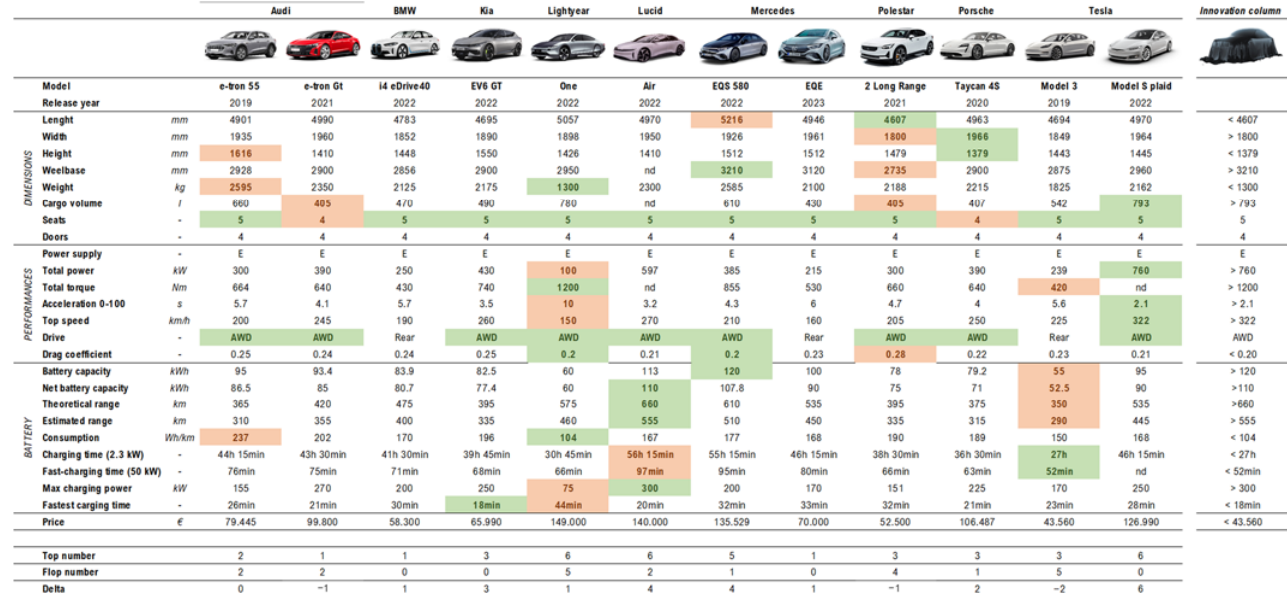
Figure 2. Benchmarking and top-flop analysis tables.